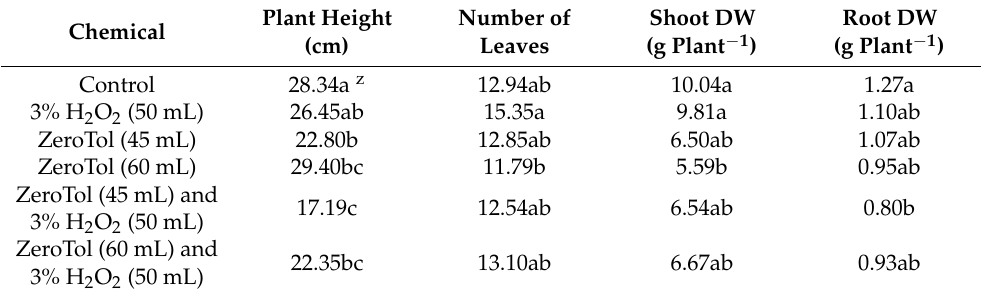
Table 3. Least square means of rates of two hydrogen peroxide products on height, leaf number, shoot dry weight, and root dry weight of lettuce (‘Tropicana’ and ‘Green Forest’) grown in ebb and flow hydroponic systems at OSU research greenhouses in Stillwater, OK, in experiment one.